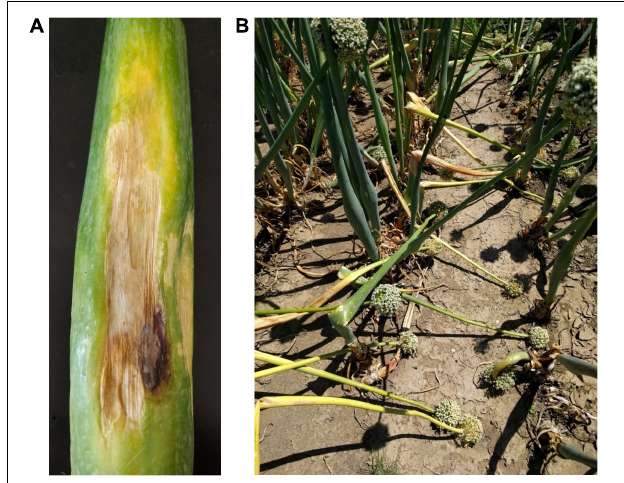
FIGURE 1 | Symptoms associated with Iris yellow spot orthotospovirus infection on onion (A) on scapes; (B) toppling of the seed